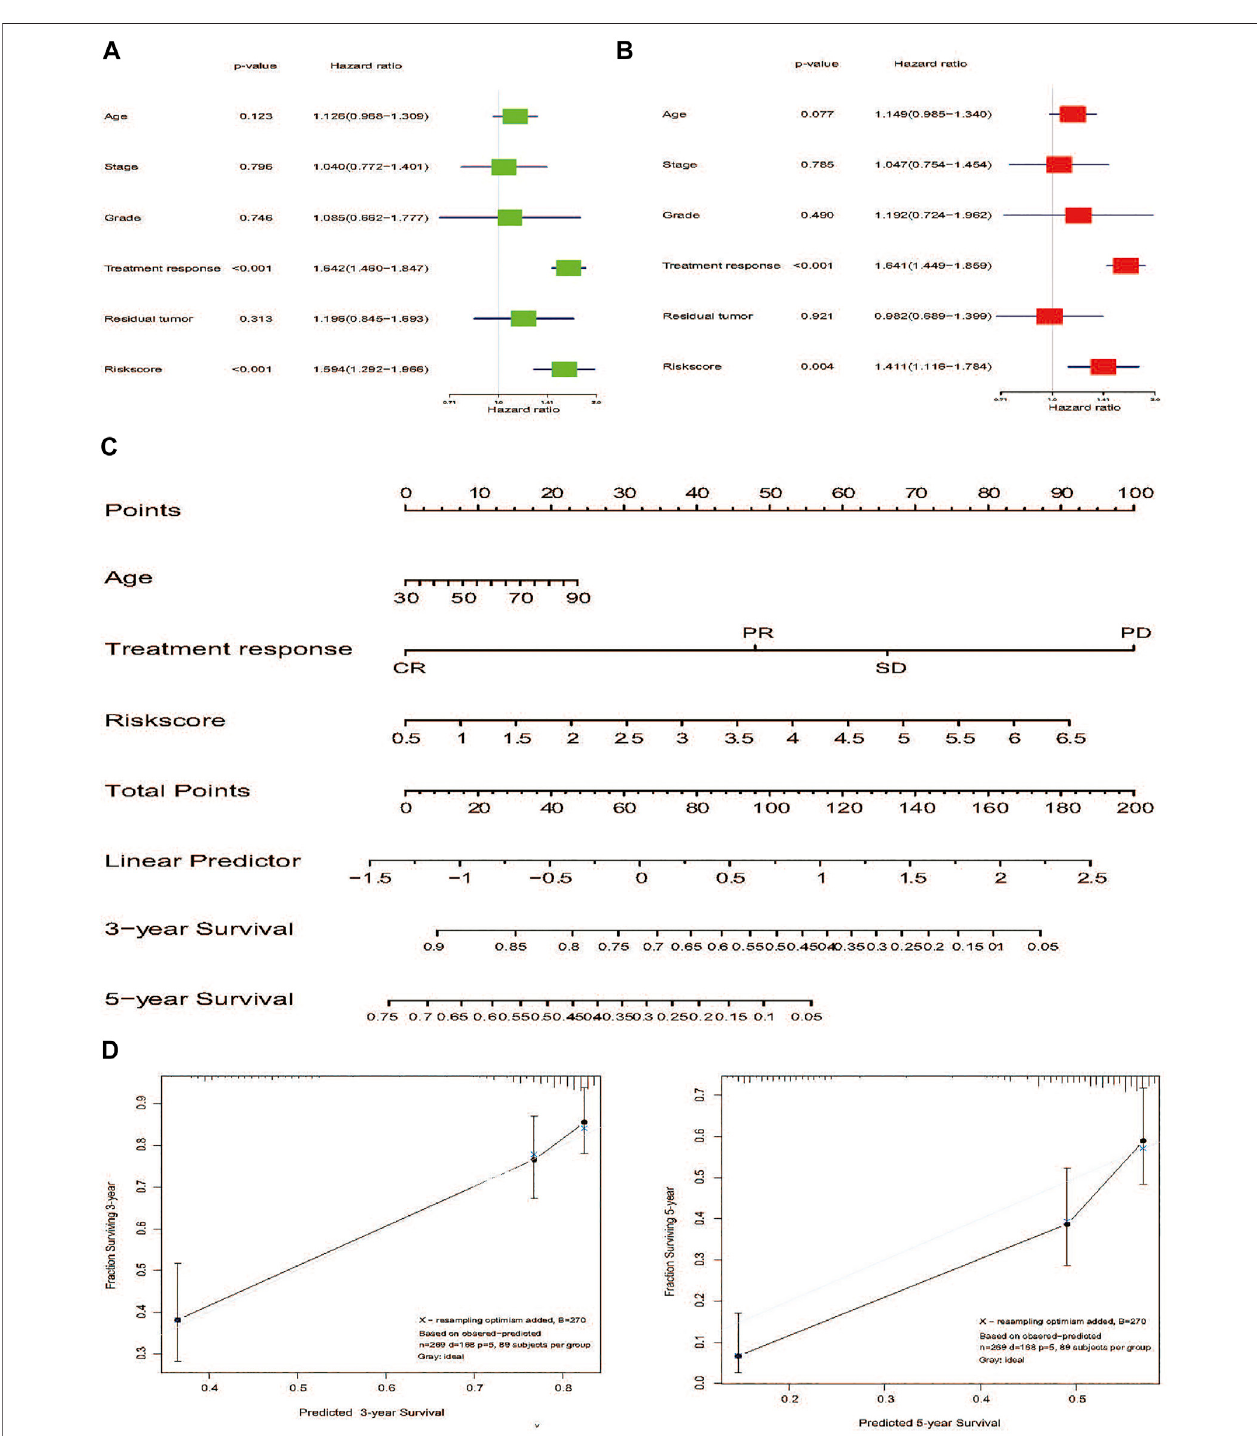
FIGURE 7 | Nomogram development of 7-gene signature to predict the risk of survial in advanced patients with HGSOC. (A) Univariate Cox regression analysis of theriskscoreandclinicopathological factorstoidentifytheindicators thatweresigni fi cantlyassociatedwithOS. (B) MultivariateCoxregressionanalysisoftheriskscore and clinicopathological parameters to reveal the independent prognostic factors. (C) A nomogram was constructed to predict three- or 5-year survival. (D) Calibration curvesofthenomogramtopredict 3-or 5-year OSinTCGA internalvalidation. Theactual OSisplottedon they-axis;nomogram predicted probability isplotted on the x-axis. Abbreviation: NER: Nucleotide excision repair; HGSOC: Highly-grade serous ovarian cancer; OS: Overall survival.